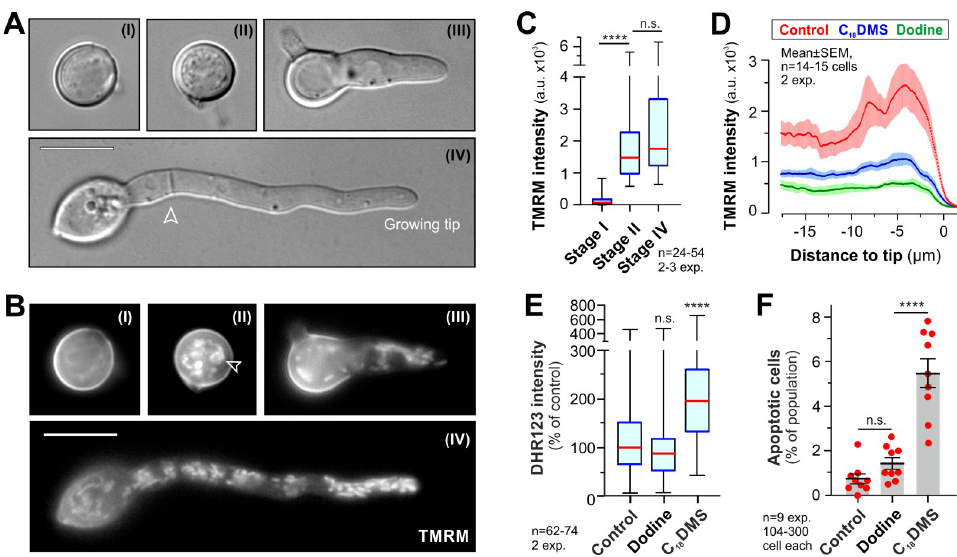
Fig 9. The MoA of C 18 DMS in germinating chlamydospores of FocTR4. A Developmental stages of chlamydospore germination in potato dextrose medium. Dormant spores appear smooth (stage I); prior to germination they appear granular (stage II). Single germ tubes emerge, which form septa (arrowhead), extend at their growing tip and develop into hyphae (stage IV). Scale bar = 10. B Mitochondrial membrane potential, visualised by the cell-penetrating dye TMRM, in chlamydospores at different stages of germination. Note that almost no TMRM staining is seen in un- germinated spores (stage I), but mitochondria-associated fluorescence appear shortly before the germ tube emerges (stage II; arrowhead). Scale bar = 10 μ m. C Mitochondrial membrane potential, indicated by TMRM fluorescence, in chlamydospores at stage (I) and (II) and in the germ tube (IV). D Intensity profile of TMRM fluorescence, indicative of mitochondrial membrane potential, along germ tubes of 7 h-old germlings of FocTR4, treated with the solvent (red curve), C 18 DMS (blue curve) and dodine (green curve). Values are shown as mean ± SEM of 14–15 germlings. Note that both MALCs depolarises mitochondria. E Abundance of ROS, labelled with DHR123 in control, C 18 DMS- and dodine- treated FocTR4 cells. C 18 DMS induces ROS generation, whereas dodine reduces ROS. F Induction of cellular apoptosis, visualised by FITC-VAD(OMe)-FMK staining, in control, C 18 DMS- and dodine-treated FocTR4 cells. C 18 DMS alone induces apoptotic cell death. This activity was reported in Z . tritici [58]. Data in ( C, E ) are not normally distributed (Shapiro-Wilk test, P < 0.05) and are shown as Whiskers’ plots with 25/75 percentiles (blue line) and median (red line); data in ( D , F ) are given as mean ± SEM; red dots in ( F ) represent independent experiments; sample sizes indicated in all graphs; statistical comparison with control in ( F ) used Student’s t-testing with Welch correction and in ( C , E ) non- parametric Mann-Whitney testing; n.s. = non-significant difference at two-tailed P = 0.0932 ( C ), P = 0.0993 ( E ) and two- tailed P = 0.1016 ( F ); ���� = significant difference at two-tailed P < 0.0001 ( C , E , F ). Treatments were 10 μ g ml -1 , 30 min, for C 18 DMS and dodine ( D , E ) and 10 μ g ml -1 of both compounds for 24 h ( F ). Control in ( D, E, F ) indicates the use of an equivalent volume of the solvent